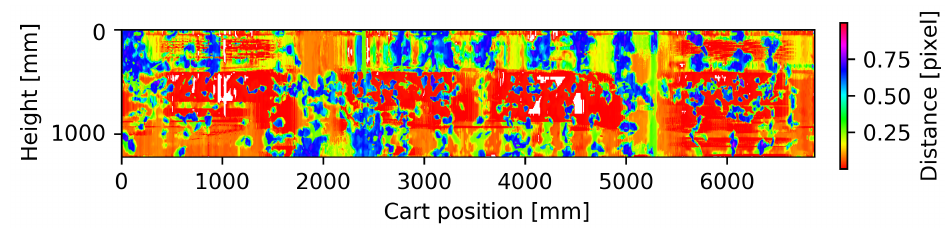
Figure 13. Elaborated data with the proposed SfF system.